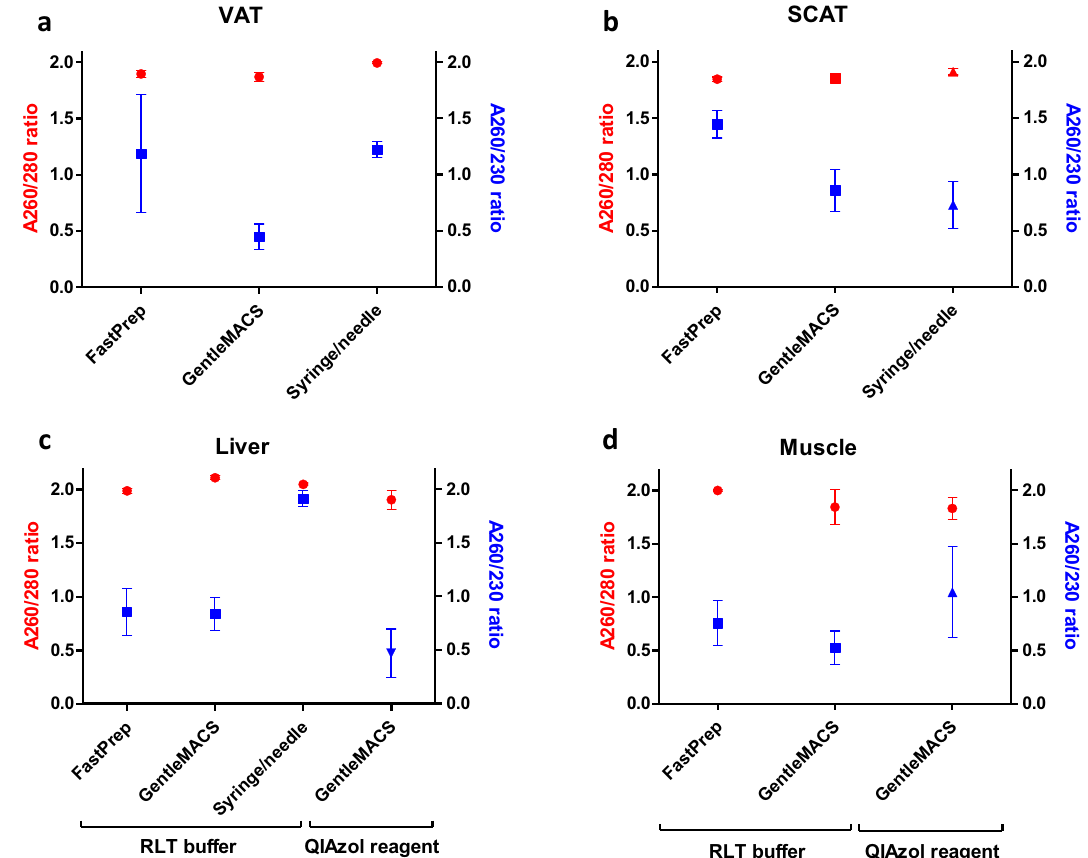
Figure 2. RNA purity after extraction with different homogenization buffers and methods. A260/280 and A260/230 ratios were determined using Nanodrop Spectrophotometer. Mean values ± SEM are shown for VAT ( a ), SCAT ( b ), liver ( c ), and muscle ( d ). VAT visceral adipose tissue, SCAT sub-cutaneous adipose tissue. FastPrep for FastPrep-24 Instrument, GentleMACS for GentleMACS